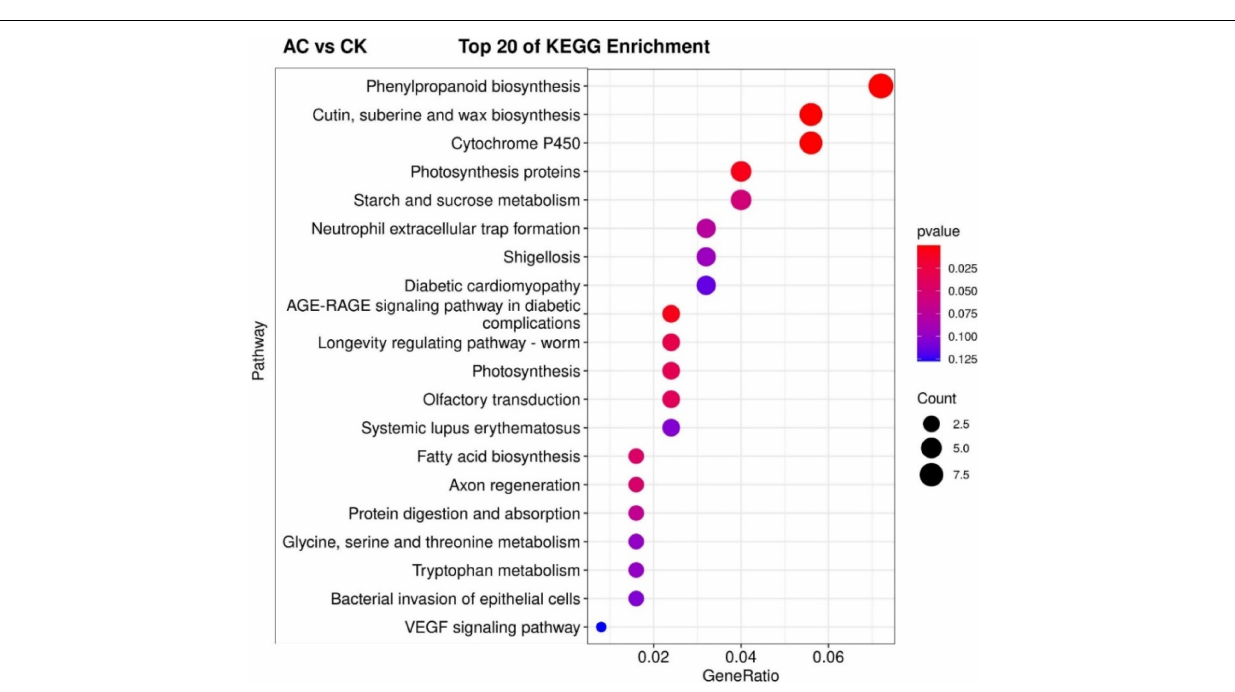
Frontiers in Plant Science |